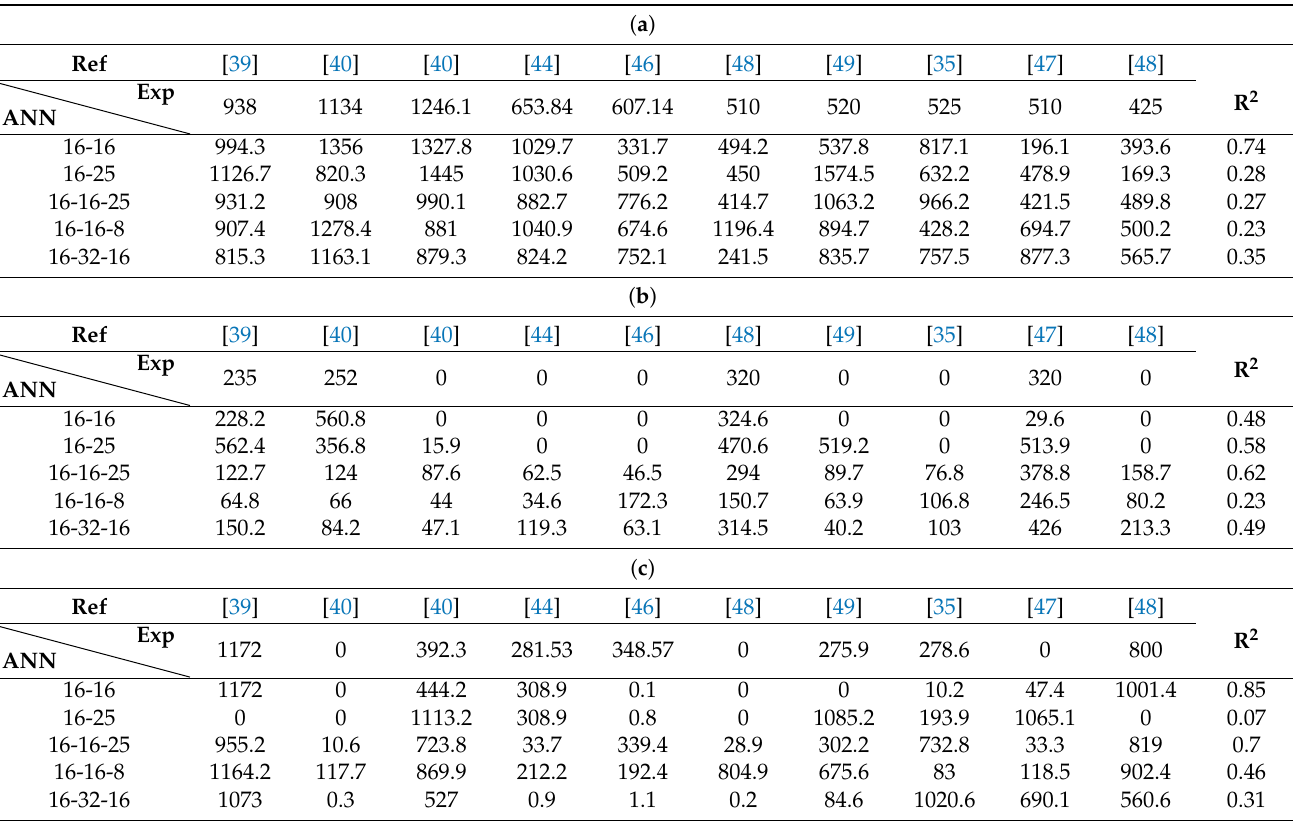
Table 4. Regression analysis results of mix design prediction ( a ) Prediction of fly ash content (kg/m 3 ); ( b ) prediction of GGBS content (kg/m 3 ); ( c ) prediction of sand content (kg/m 3 ); ( d ) prediction of activator–binder ratio; ( e ) prediction of PVA fiber V f (%); ( f ) prediction of curing temperature x